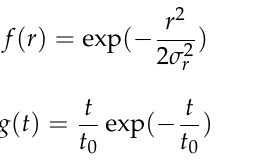
Table 1. Material properties of Cu/Al laminate applied for numerical simulation.